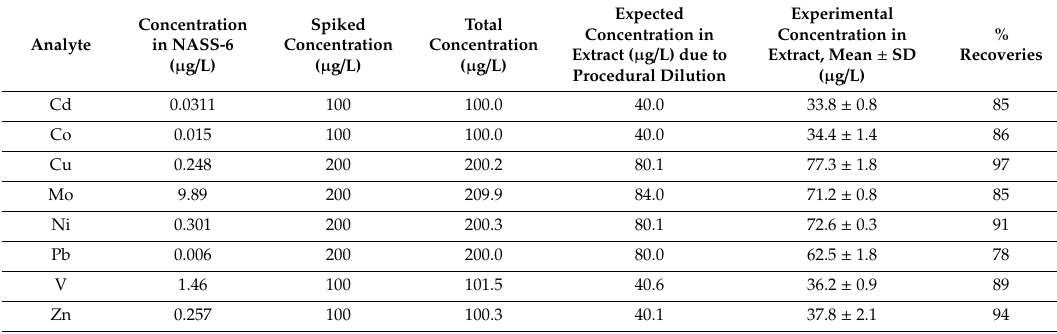
Table 2. Analyte recoveries from spiked CRM samples under optimum extraction conditions based on an external calibration curve.